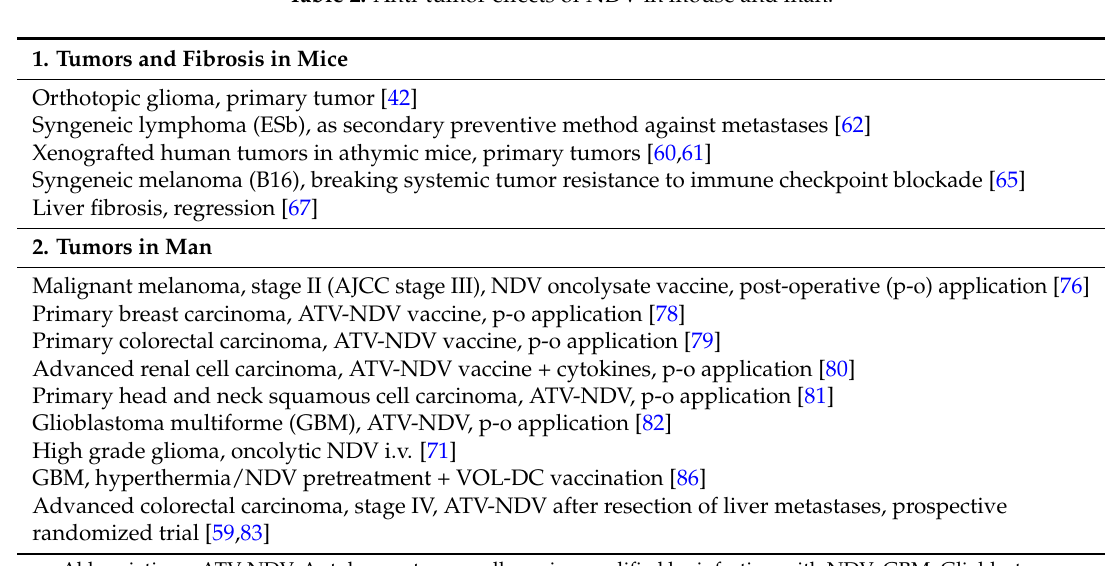
Table 2. Anti-tumor effects of NDV in mouse and